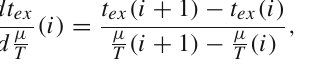
We fixed the values of interquark distance l = 0 . 27, the transi- tion time k = 3 and the temperature T = 0 . 37 ( lT = 0 . 10). The red curve is the same function fitted with the data with θ = 0 .